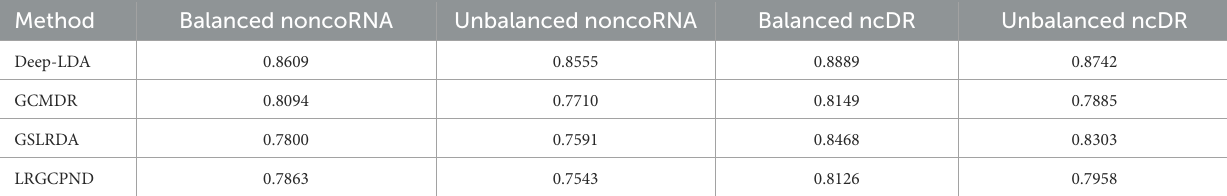
TABLE 4 Comparison of average performance metrics of different